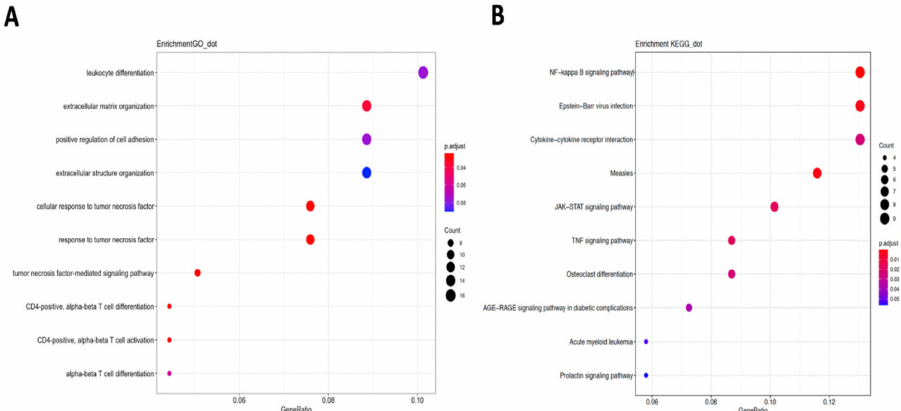
Figure 3. Gene ontology (GO) and KEGG pathway enrichment of DMD co-expressed genes in lung cancer. ( A ) All biological process enrichments of DMD co-expressed genes in lung cancer. ( B ) Kyoto Encyclopedia of Genes and Genomes analysis of the functional meanings of DMD co-expressed genes in lung